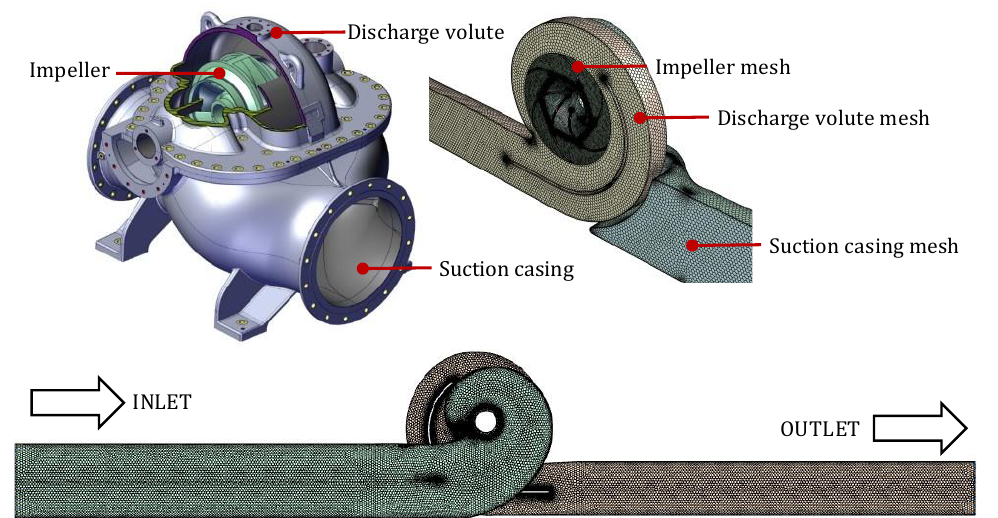
Figure 2. Overview of the numerical domain.